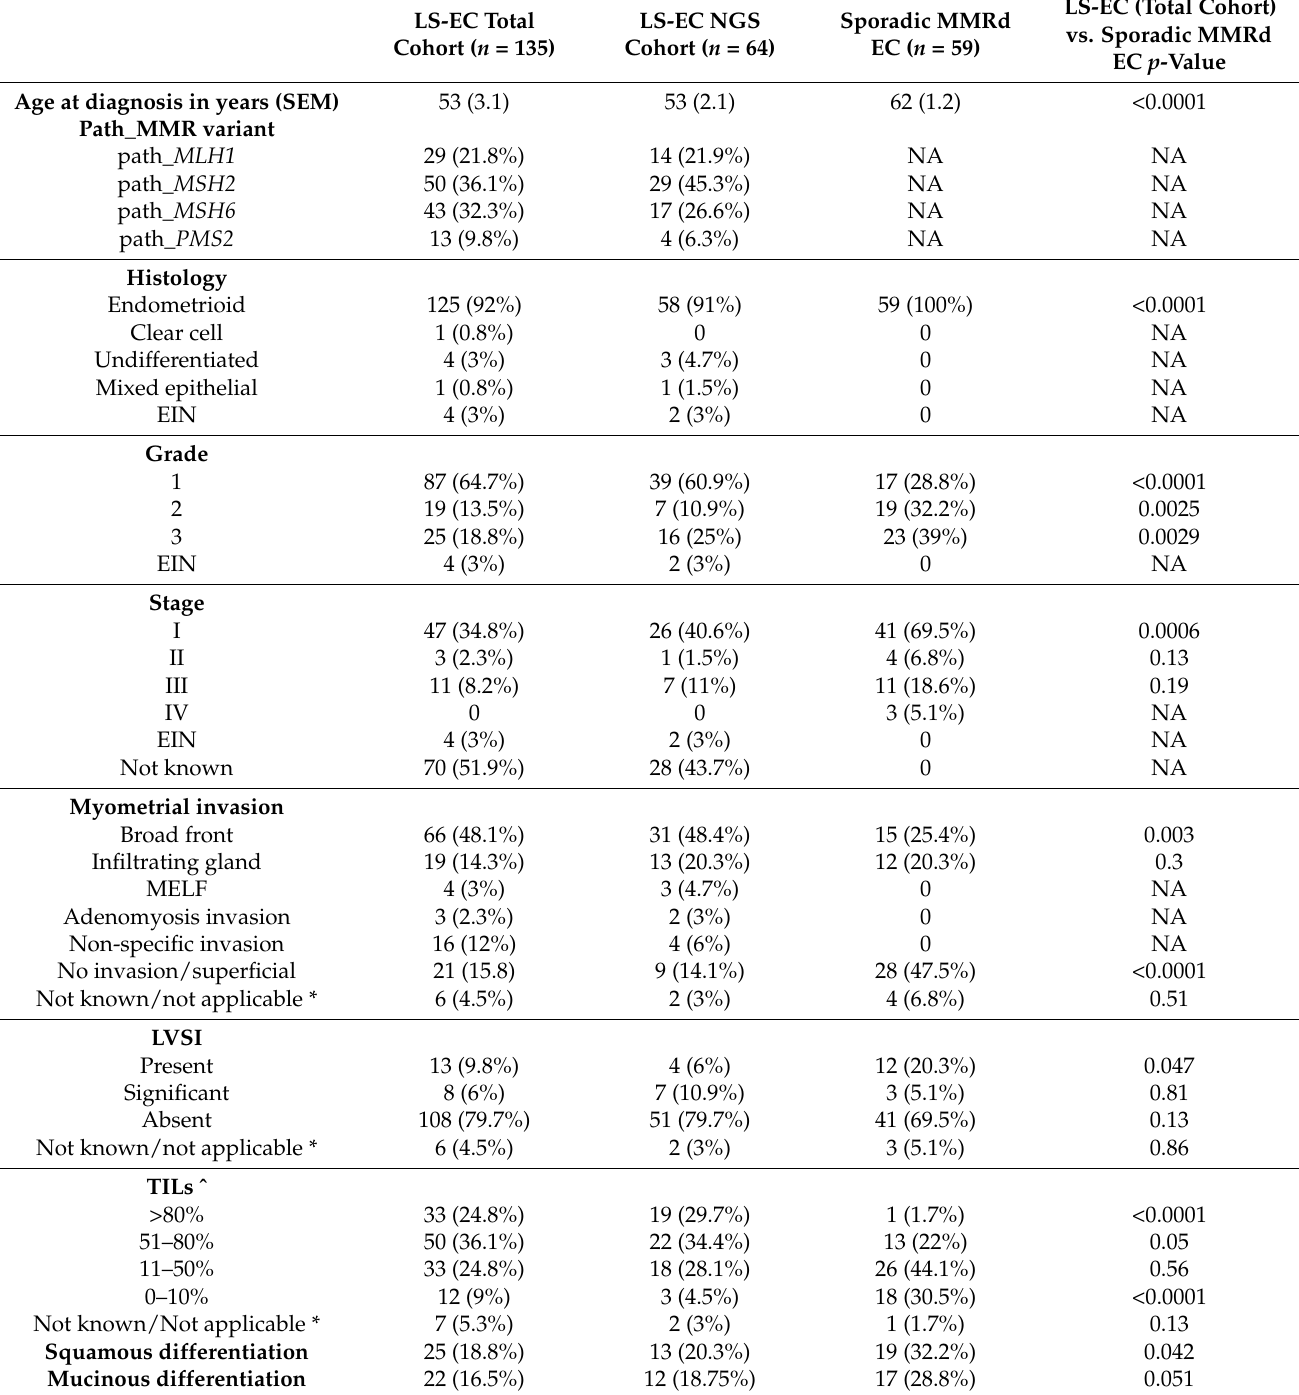
Table 1. Demographic and pathological features of the LS-EC and sporadic MMRd EC